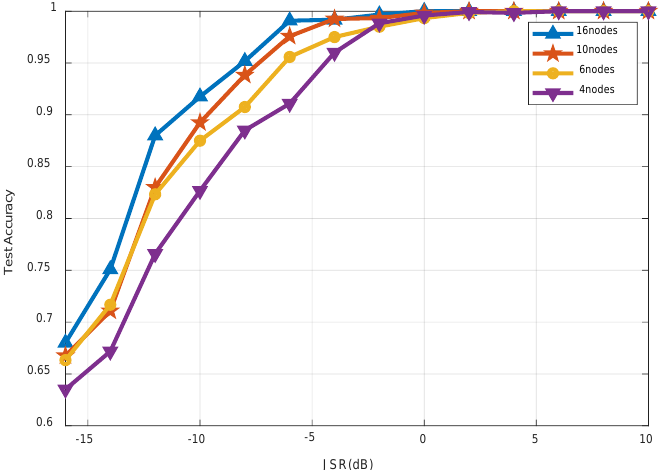
Figure 10. Performance comparison of soft-fusion based methods under a different number of nodes.